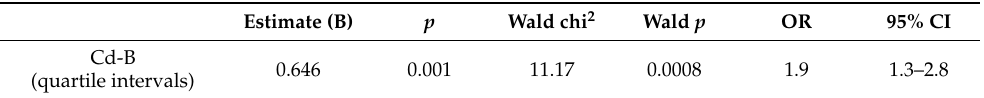
Table 5. Results of univariate logistic analysis assessing the effect of Cd-B on the probability of inflammatory arthritis in the study